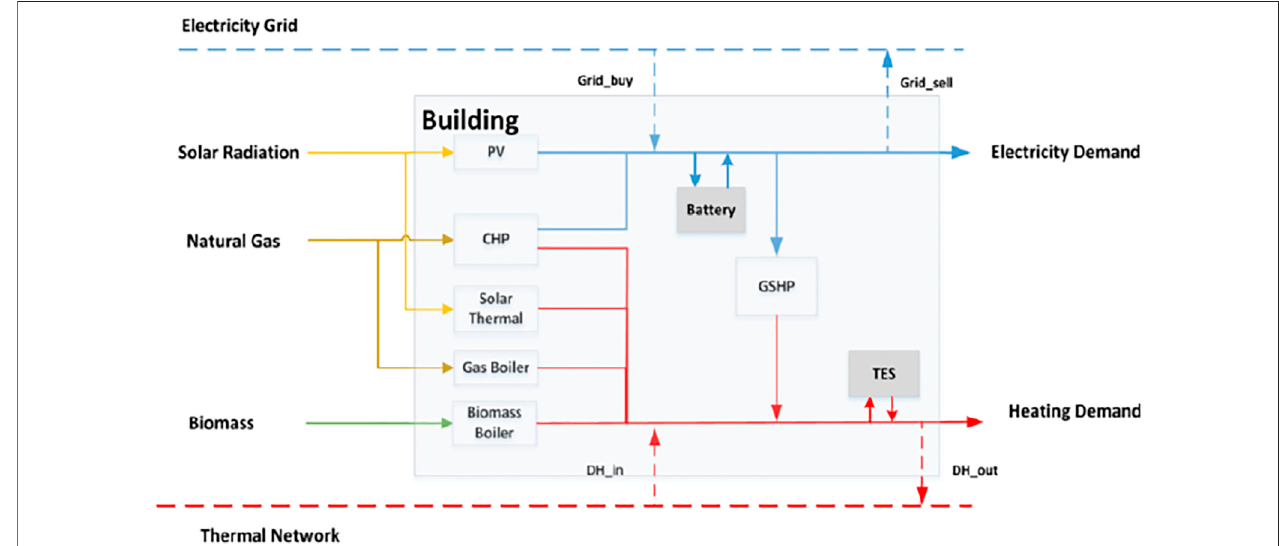
FIGURE 2 | Candidate set of energy technologies and energy fl ow for the D-MES at each